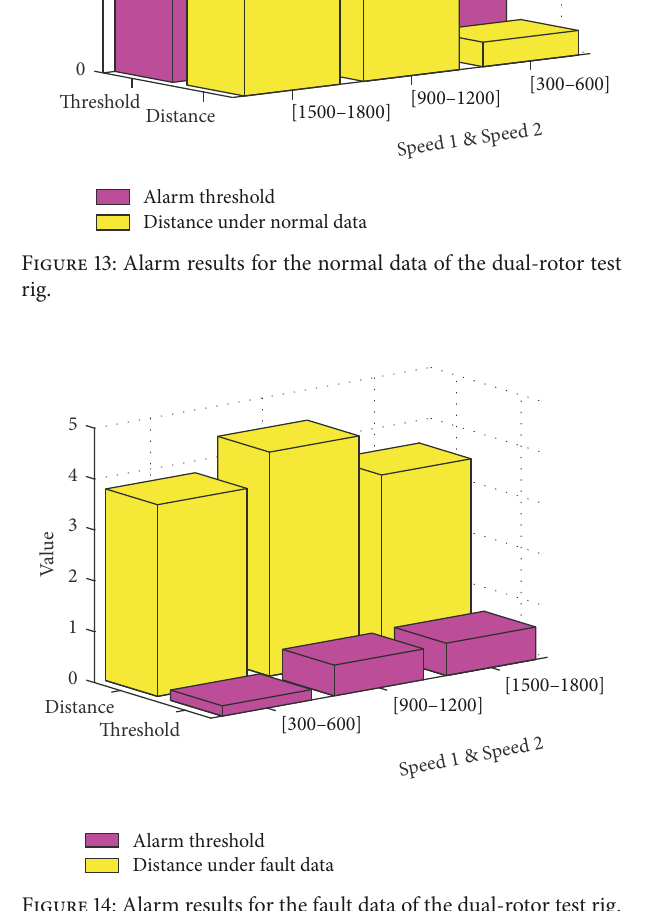
Figure 14: Alarm results for the fault data of the dual-rotor test